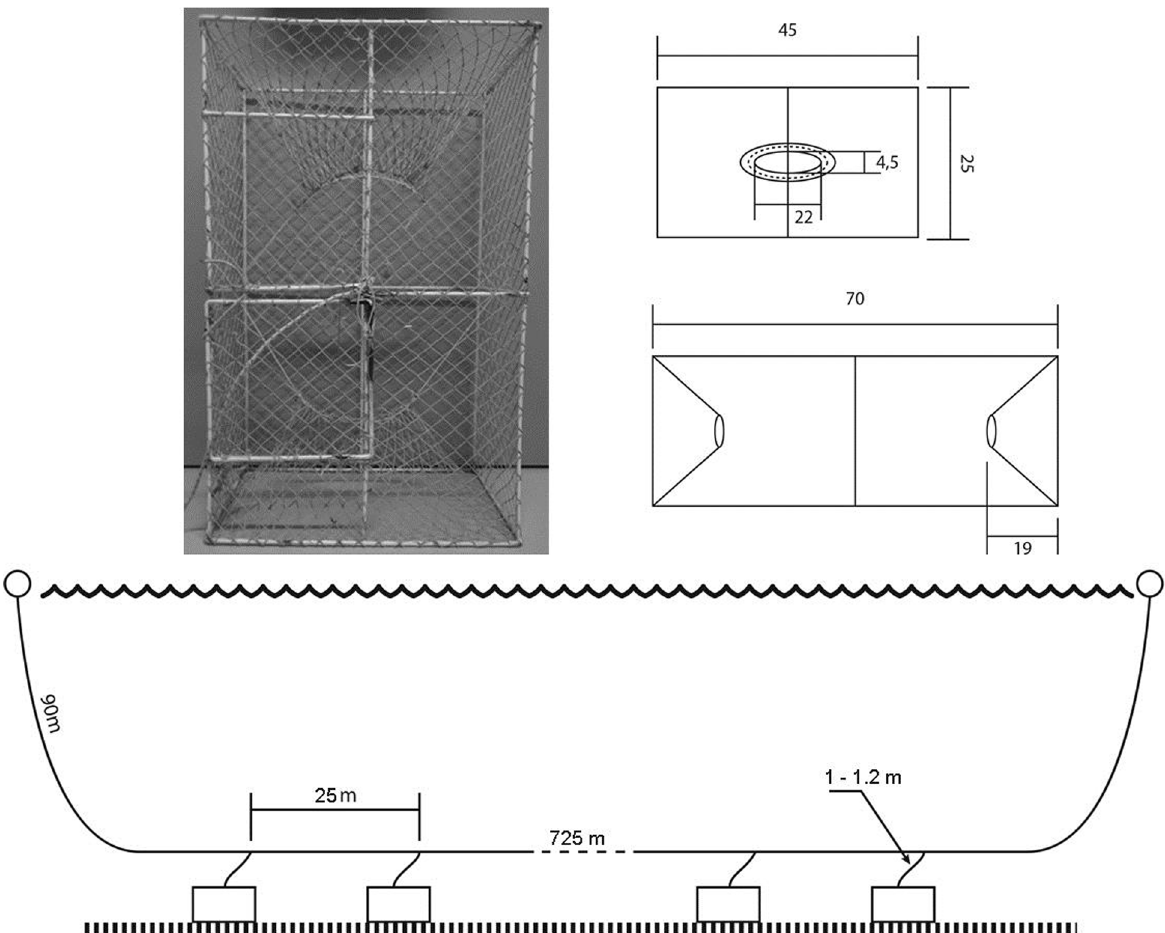
Fig. 2. Photo and technical drawing of the creel used in the study and schema view of the deployment in the longline